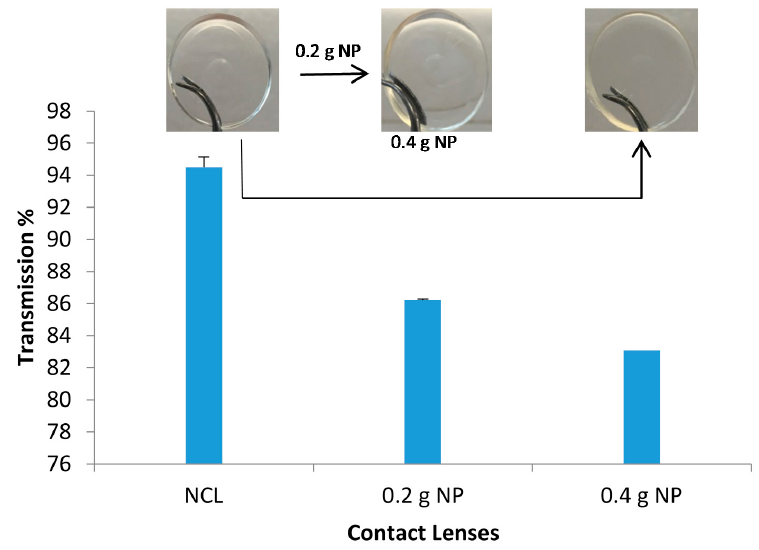
Figure 9. Light transmission through contact lenses at visible wavelength of 600 nm. Data are presented as mean ± standard deviation, n = 3).